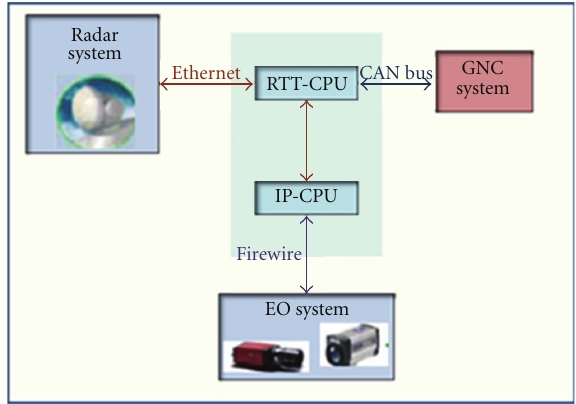
Figure 2: DS&A system hardware